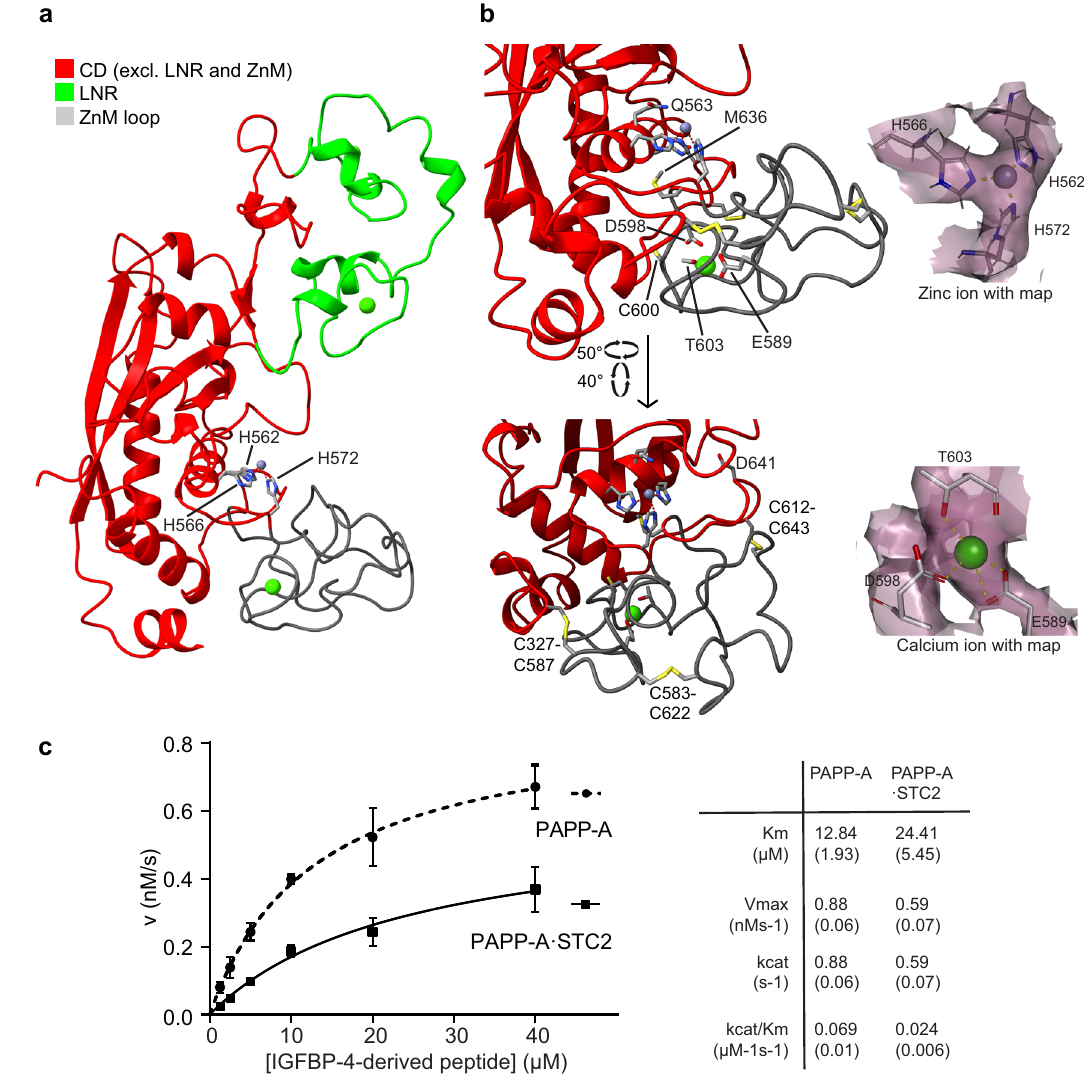
Fig. 4 | The catalytic domain (CD) of the PAPP-A subunit. a Cartoon repre- sentationoftheisolatedCD(red)withtheZnMloop(gray)andthetwoinsertedLNR modules (LNR1-2, green) colored separately. Thiscolor scheme isused throughout the fi gure. The active site cleft, containing the Zn 2+ ion coordinated by three histi- dine residues (H562, H566, H572), is facing right and located between the LNR modulesand theZnM loop. b Enlarged viewof theactivesitecleftoftheCDshown in two orientations. The methionine residue of the Met-turn(M636) is indicated. In the position of the glutamic acid residue (E563), which serves to polarize a water molecule involved in nucleophilic attack at the scissile peptide bond, is shown a glutamine residue, present in the recombinant protein (E563Q) used in this study.